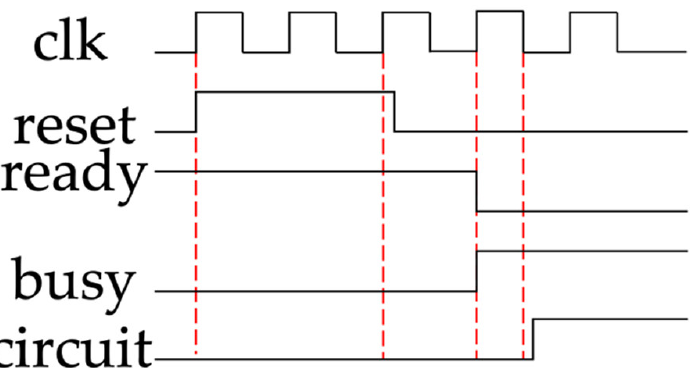
Figure 6. The real signal indicates that “CLK” represents the signal of the clock, and “circuit” represents the action of the computing circuit, and the other things that are not mentioned are related to the above-mentioned signals. The red dotted line represents the alignment of the signals.